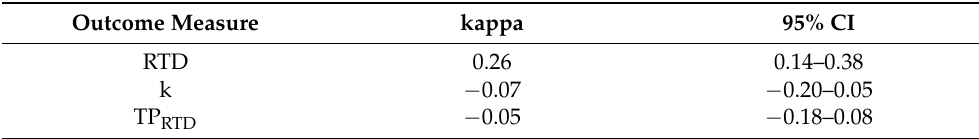
Table 2. Absolute and inter-limb symmetry values (mean ± SD) of knee extensors for different outcome measures. Group